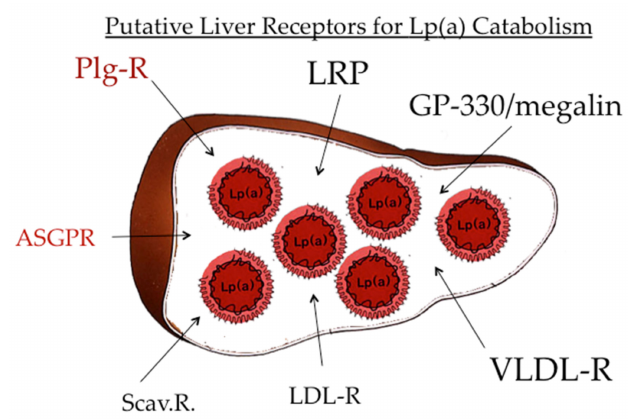
Figure 8. Catabolism of Lp(a). The majority of Lp(a) is not only biosynthesized but also catabolized in the liver. Numerous receptors bind Lp(a) in vitro; however, their impact on in vivo catabolism is not fully explored. Of interest is the binding of Lp(a) to the plasminogen receptor and the asialoglycoprotein